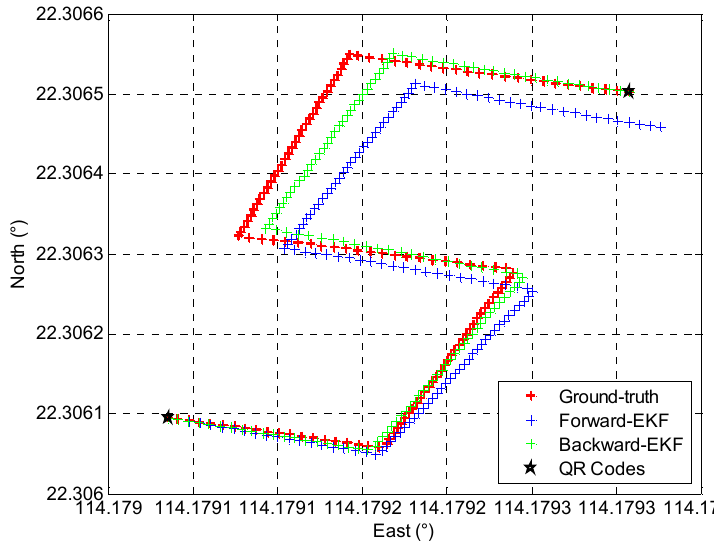
Figure 7. Comparison of Collected Trajectories.